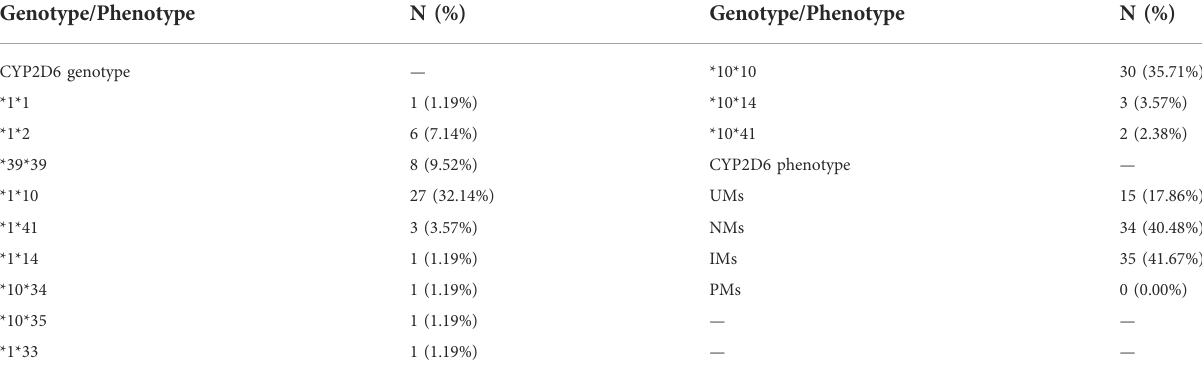
TABLE 2 The distribution of CYP2D6 genotypes and